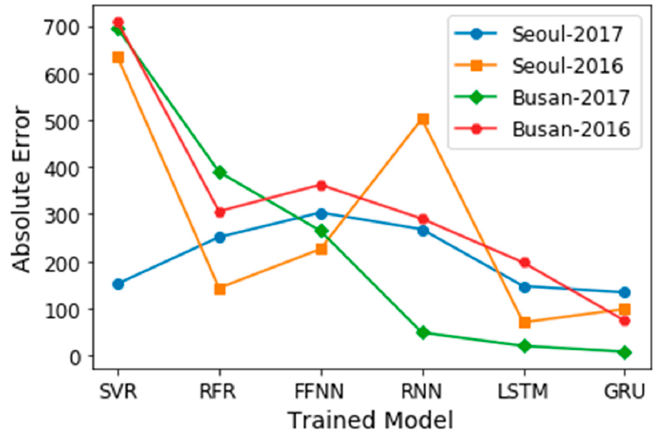
Figure 11. Absolute errors of trained models in total yearly radiation.